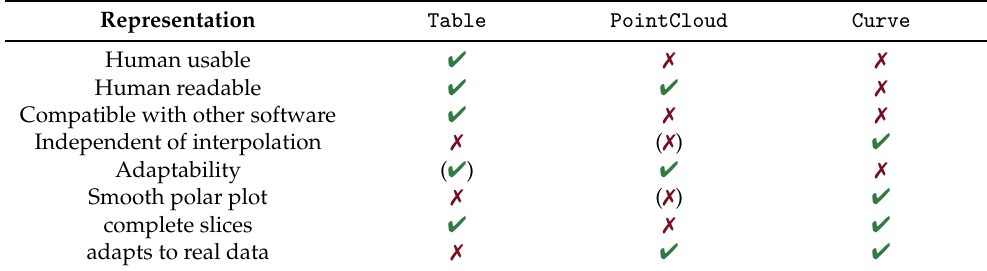
Table 1. Table of advantages and disadvantages of different representations of polar diagrams. We use () to indicate that the corresponding feature is present to some degree. Representation Table PointCloud Curve Human